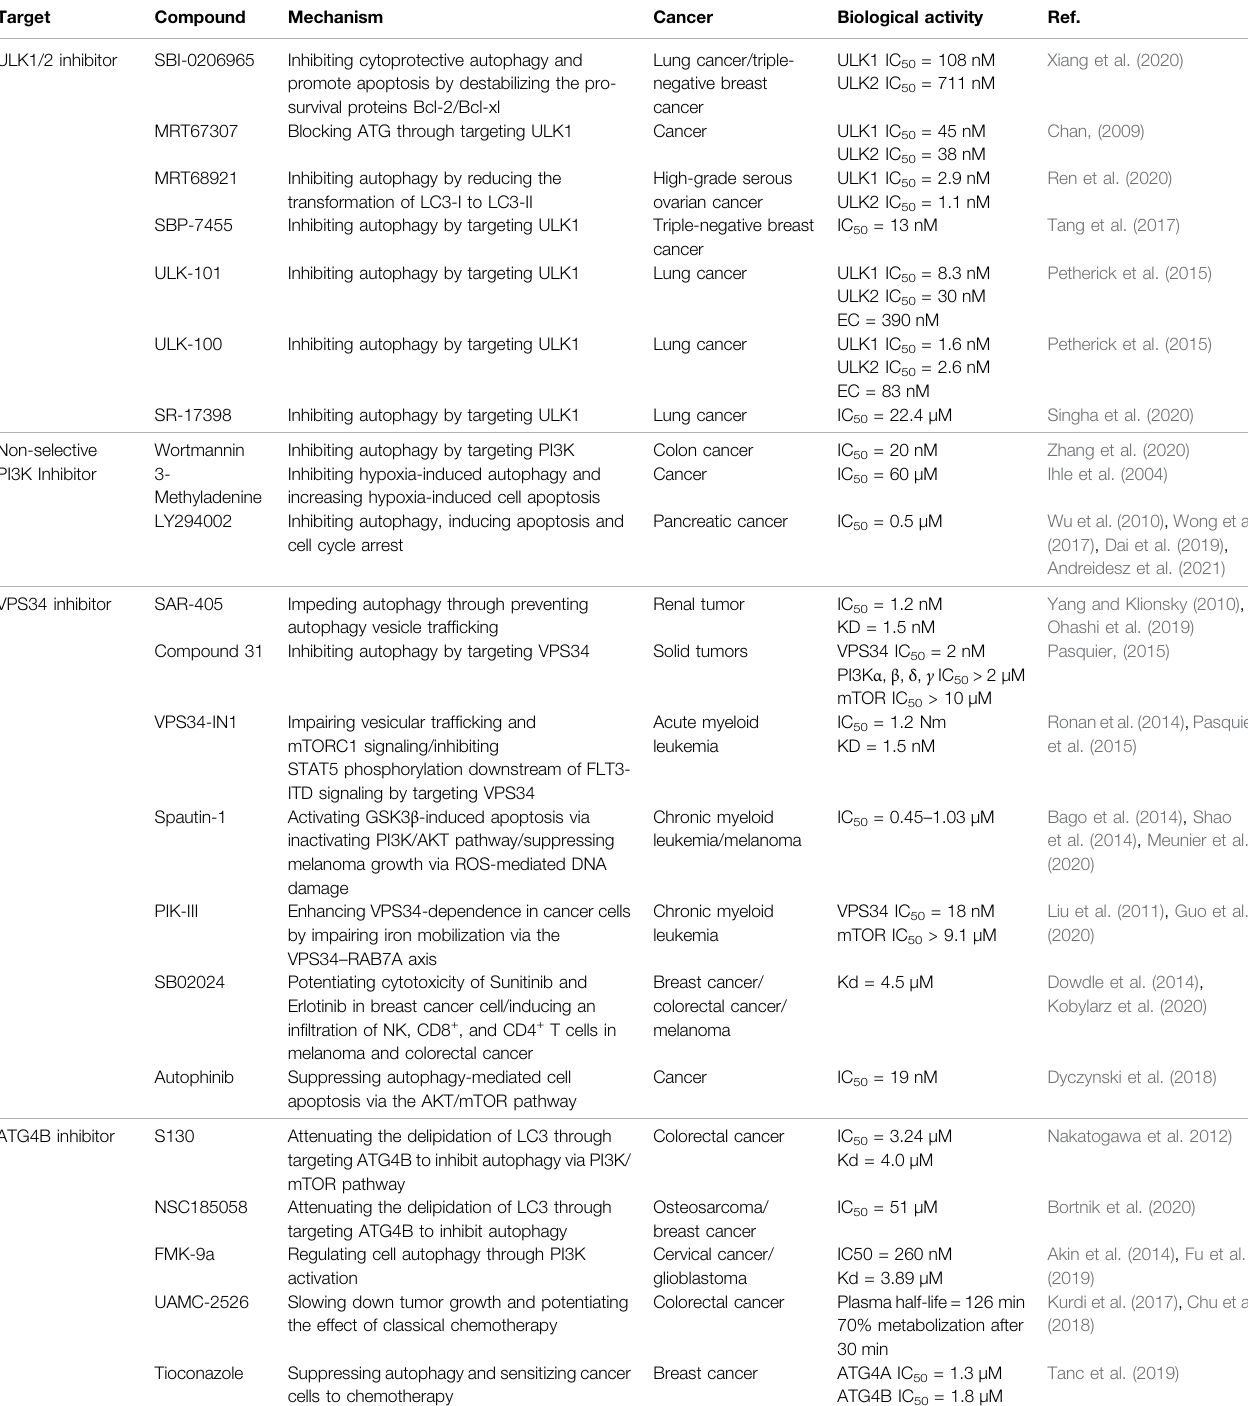
TABLE 1 | Small-molecule compounds for inhibiting autophagy in cancer